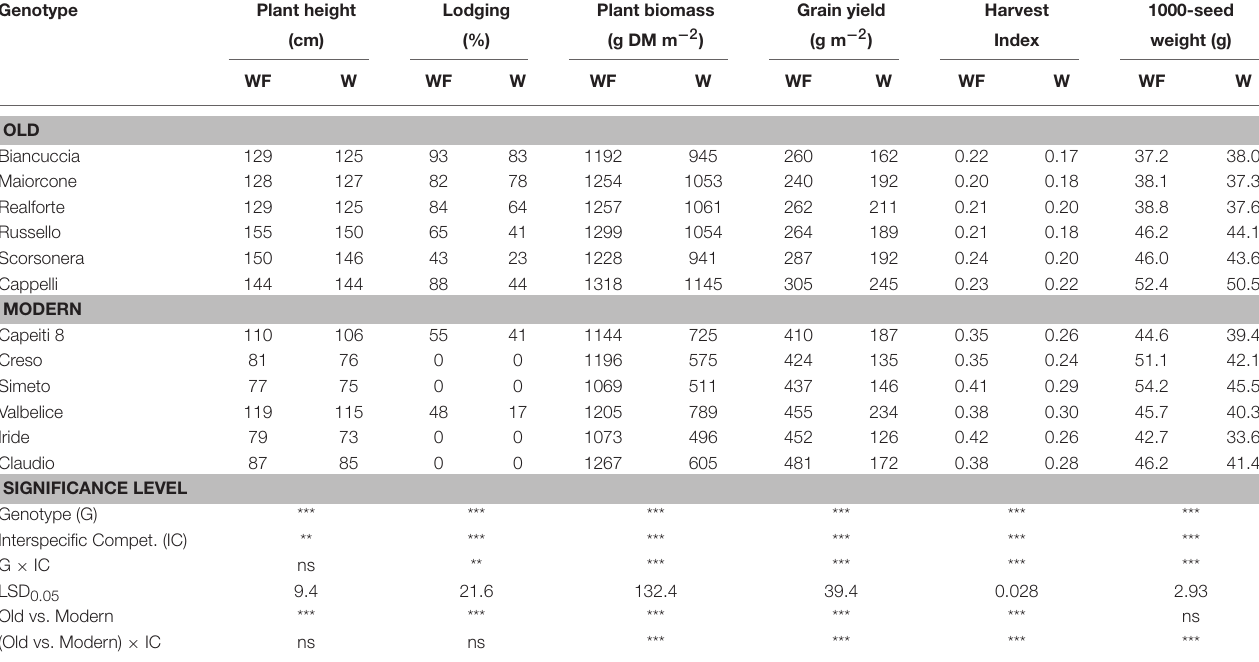
TABLE 4 | Wheat traits measured at plant maturity in 12 genotypes grown in weed-free (WF) and weedy (W) conditions.